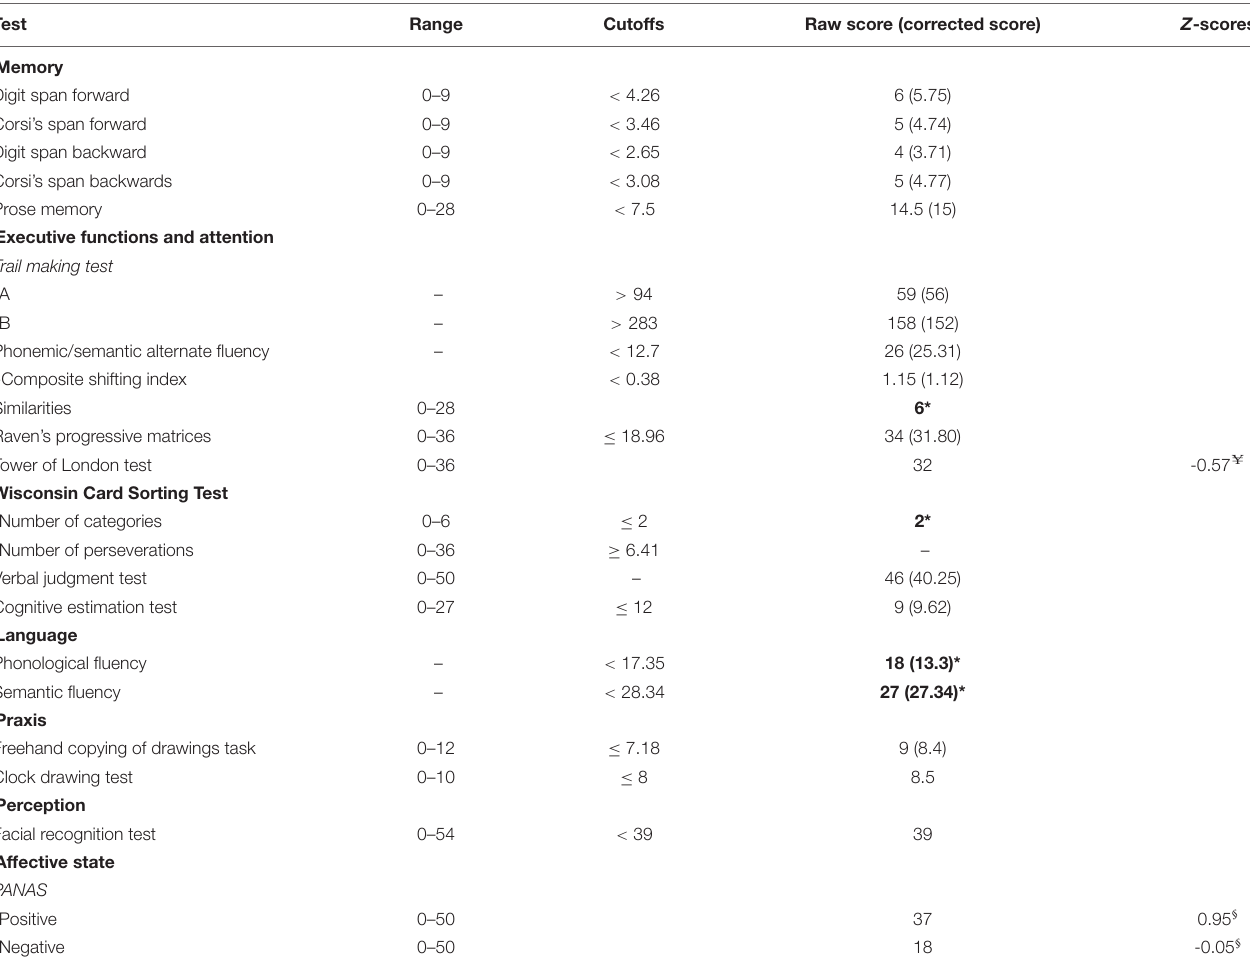
TABLE 1 | Neuropsychological battery and